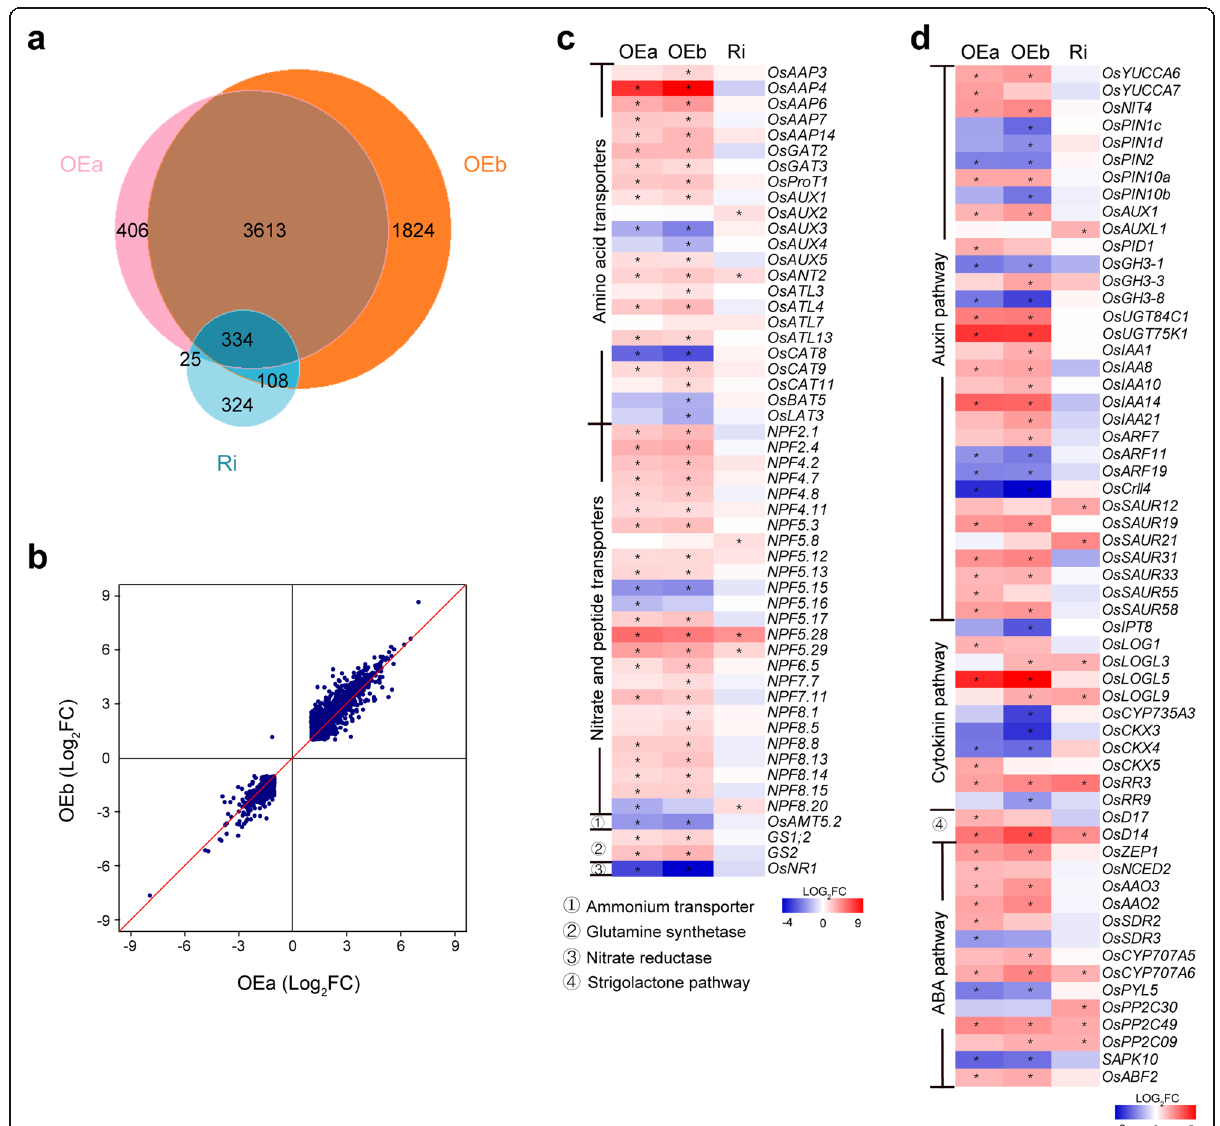
Fig. 7 Transcriptome analysis of OsAAP4 transgenic plants in the growing axillary buds. a Identification of differentially expressed genes (DEGs) in the axillary buds of OEa, OEb, and Ri lines of OsAAP4 and wild-type ZH11 (adjusted P -value <0.05 and fold change >2). b Scatter plot of different genes compared OEa and ZH11, with OEb and ZH11. c - d Heatmap visualization of expression profiles of DEGs in nitrogen transport and metabolism ( c ), auxin, cytokinin, SL, and ABA signaling pathways ( d ). Red boxes show up-regulation, and green boxes show